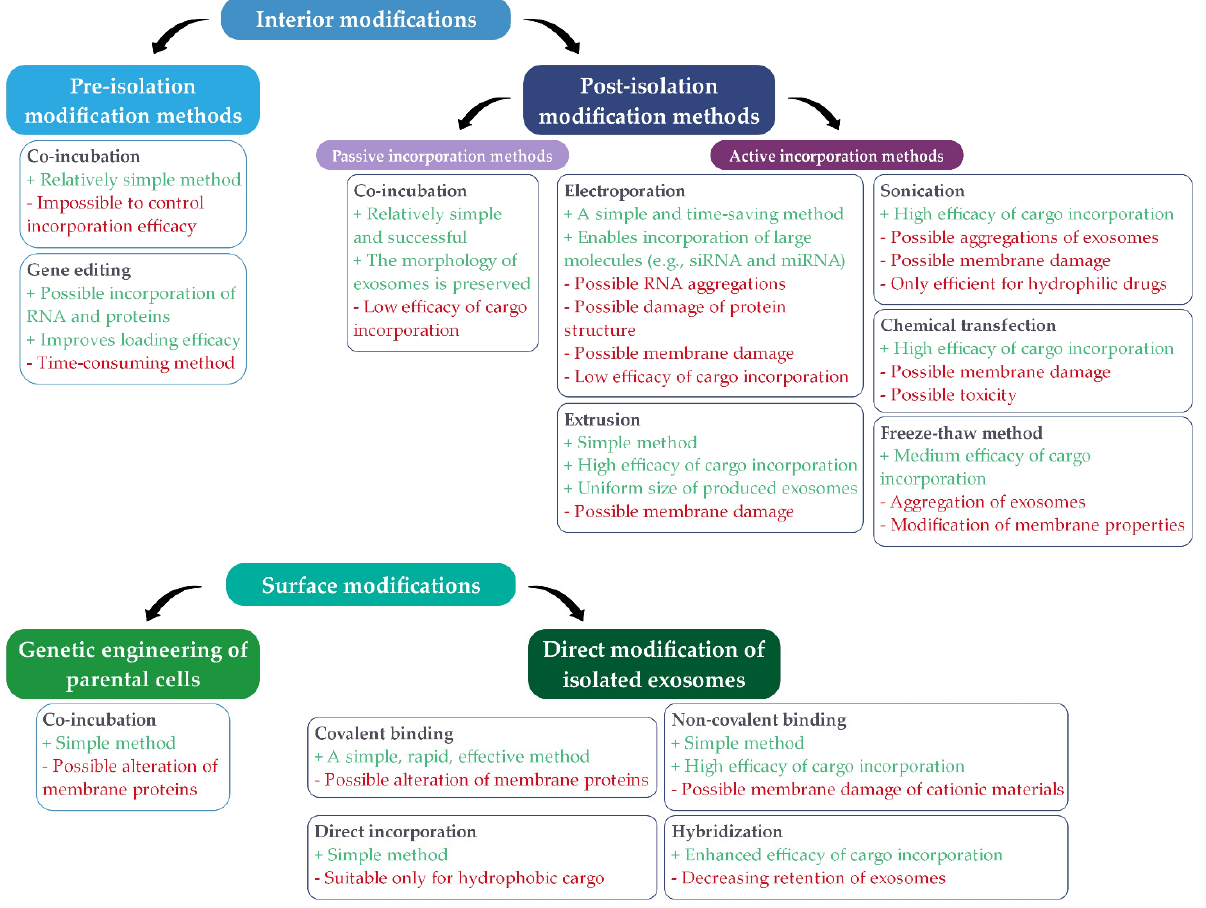
Figure 9. The main advantages (green) and disadvantages (red) of exosome preparation methods for interior (pre-isolation and post-isolation modification methods) and surface modifications (genetic engineering of parental cells and direct modification of isolated exosomes; summarized from [7,11,14,16,78,85,89,90,94–96]).